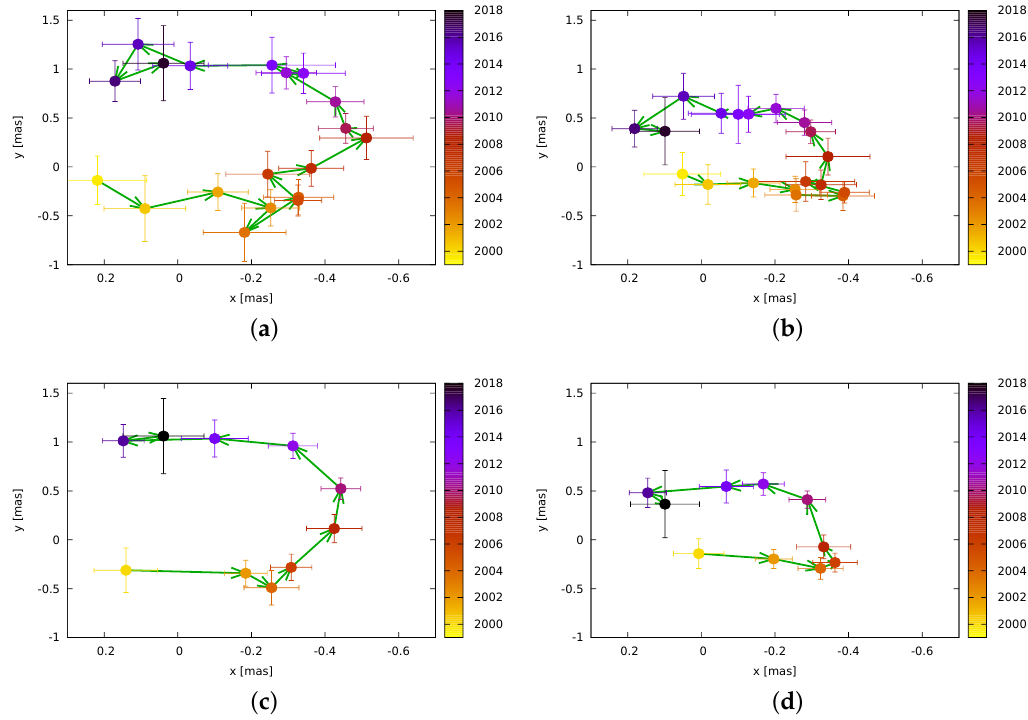
Figure 5. ( a ) Average values for the data in yearly intervals shown in Figure 4. To indicate the amount of source structure that moved, we show the uncertainties as well. The green arrows indicate the direction of the precessing motion. ( b ) The same relation as in ( a ) but averaged over two years in time. ( c ) Flux-density weighted average values in yearly intervals and averaged in two years in ( d ). The TeV flare observed by the MAGIC collaboration [30] occurs at the time of the projected reversal of the precessing motion—between the last two data points (dark blue and